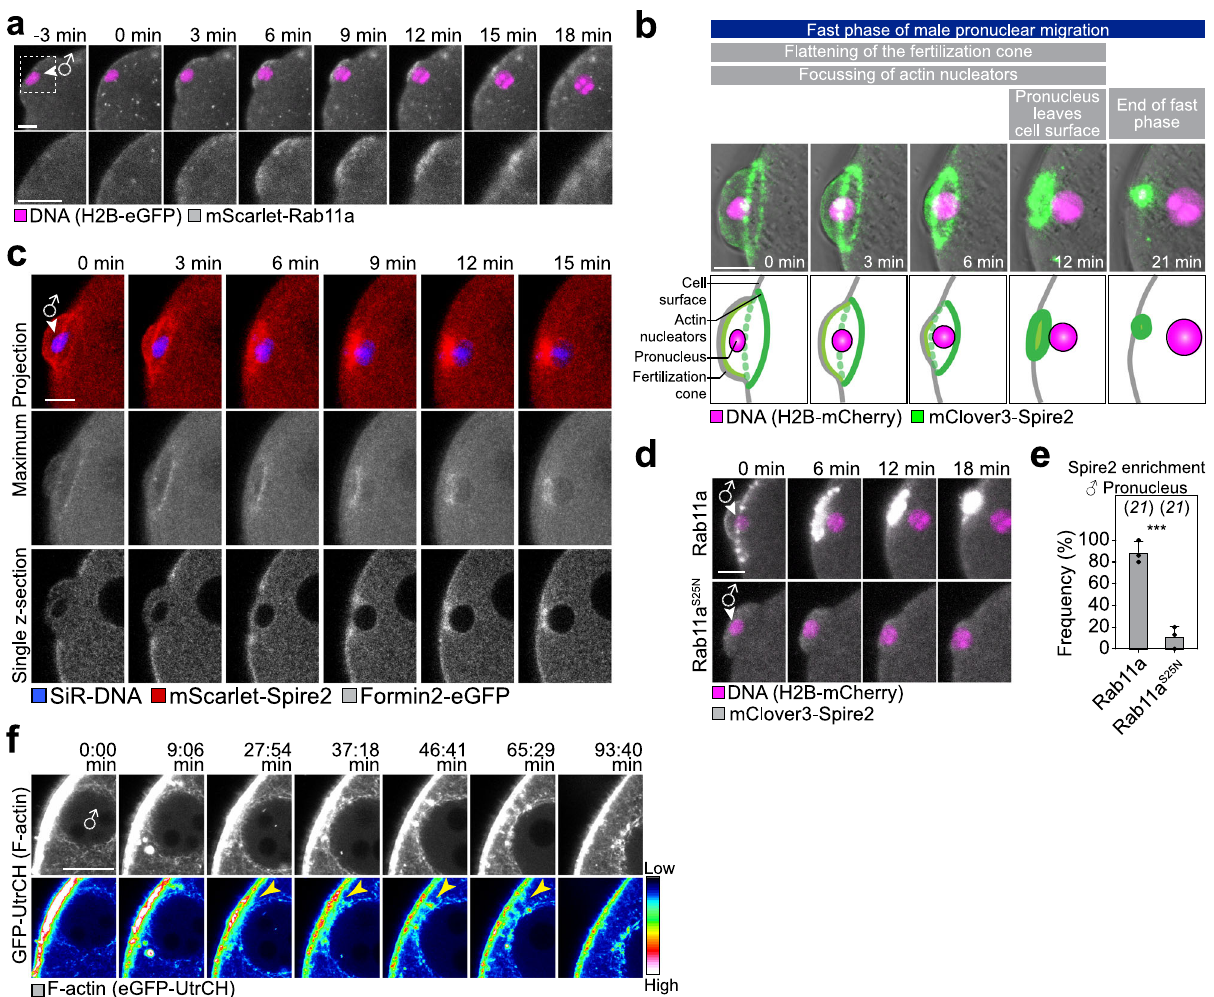
Fig. 4 Rab11a, Spire, Formin-2 and actin accumulate in the fertilization cone. a Three-dimensional time-lapse images of mScarlet-Rab11a and male pronucleus ( ♂ , H2B-EGFP) relative to pronuclear formation (0 min) in live zygotes (z-projection of seven sections, every 1.5 µ m). The region outlined in the overview is magni fi ed in the bottom panel. b Three-dimensional time-lapse images of mClover3-Spire2 and male pronucleus ( ♂ ) relative to pronuclear formation (0 min) in live zygotes (z-projection of 20 sections, every 1.5 µ m). Below, schematic depicting the stages of the fast migration phase of pronuclei from time point of pronuclear formation until pronucleus is launched off the cell surface. c Three-dimensional time-lapse images of mClover3-Spire2, Formin-2-EGFP and male pronucleus ( ♂ ) relative to pronuclear formation (0 min) in live zygotes (top, z-projection of 20 sections, every 1.5 µ m or bottom, single planes of middle slices of male pronucleus). d Three-dimensional time-lapse images of mClover3-Spire2 and male pronucleus ( ♂ ) in live zygotes expressing SNAP-Rab11a or SNAP-Rab11a S25N . e Histogram showing percentage of SNAP-Rab11a- or SNAP-Rab11 S25N -expressing zygotes with cortical mClover3-Spire2 enrichment quanti fi ed from ( d ). Data are mean ± s.d. from three independent experiments. The total number of analyzed zygotes is speci fi ed in italics. Two-tailed Student ’ s t test was used to test for signi fi cance ( p = 0.0007). f Super-resolution (airyscan) time-lapse images of F-actin (single section) displayed in grayscale (top) and fl uorescence intensity map (bottom, pseudocolour, 12-Bit grayscale) in live zygotes in proximity of the forming male pronucleus ( ♂ ). Corresponding look-up table is shown as a colour scale bar ranging from intensity levels 1 (low) to 4096 (high). Time point 0 min marks the start of acquisition. Yellow arrowheads mark increased F-actin levels between cell cortex and male pronucleus. Scale bars, 10 μ